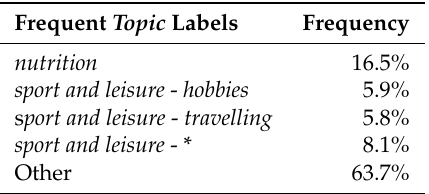
Table 3. Frequencies of the most frequent topic labels. The sets marked with the symbol * include all the labels under a given label, and also the cases where the annotator has not selected any sub-label.